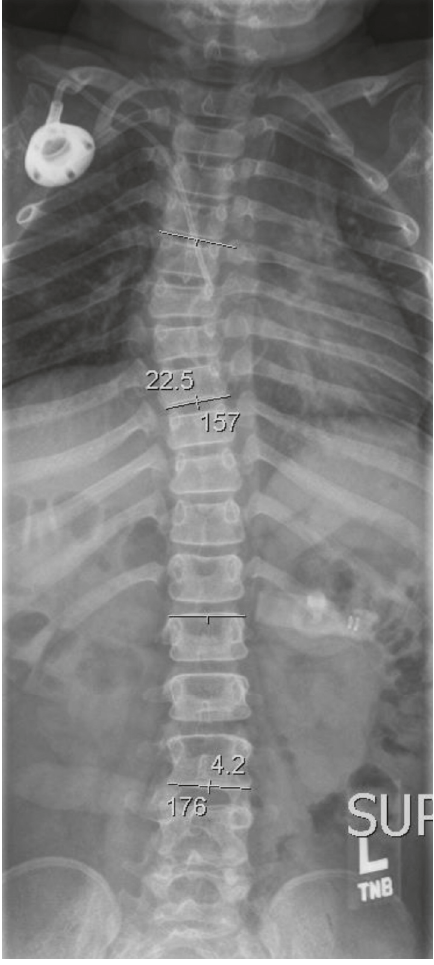
Figure 2: Scoliosis survey revealing 23 degrees of dextrocurvature of the thoracic spine, 4 degrees of levocurvature of the upper lumbar spine, and diffuse osseous